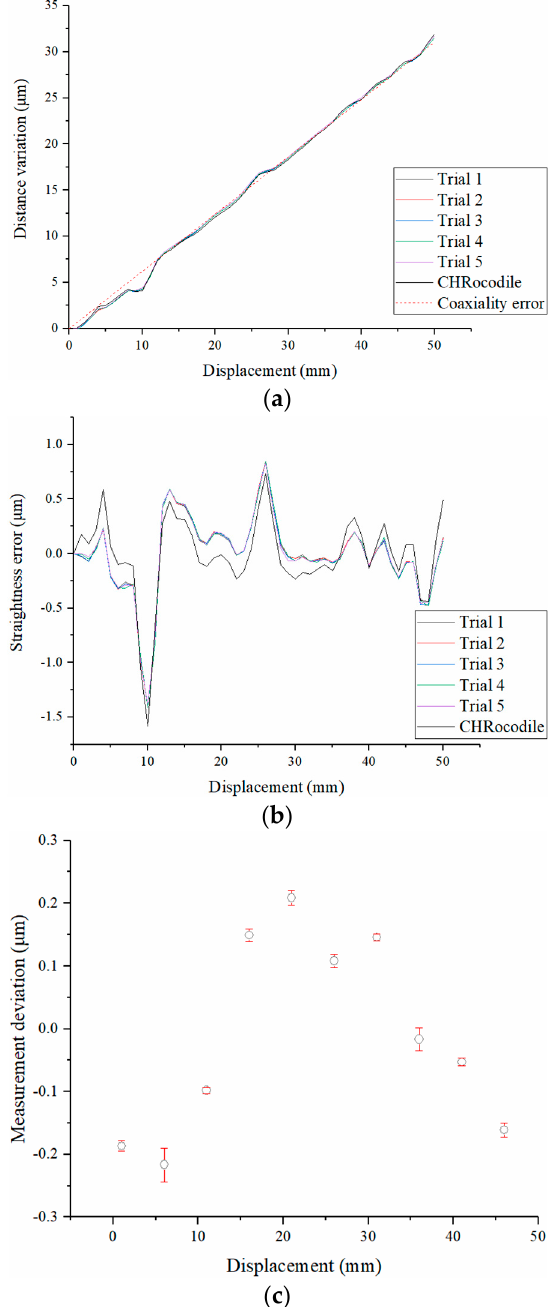
Figure 13. Experimental results: ( a ) distance variation; ( b ) straightness error; ( c ) measurement deviation.